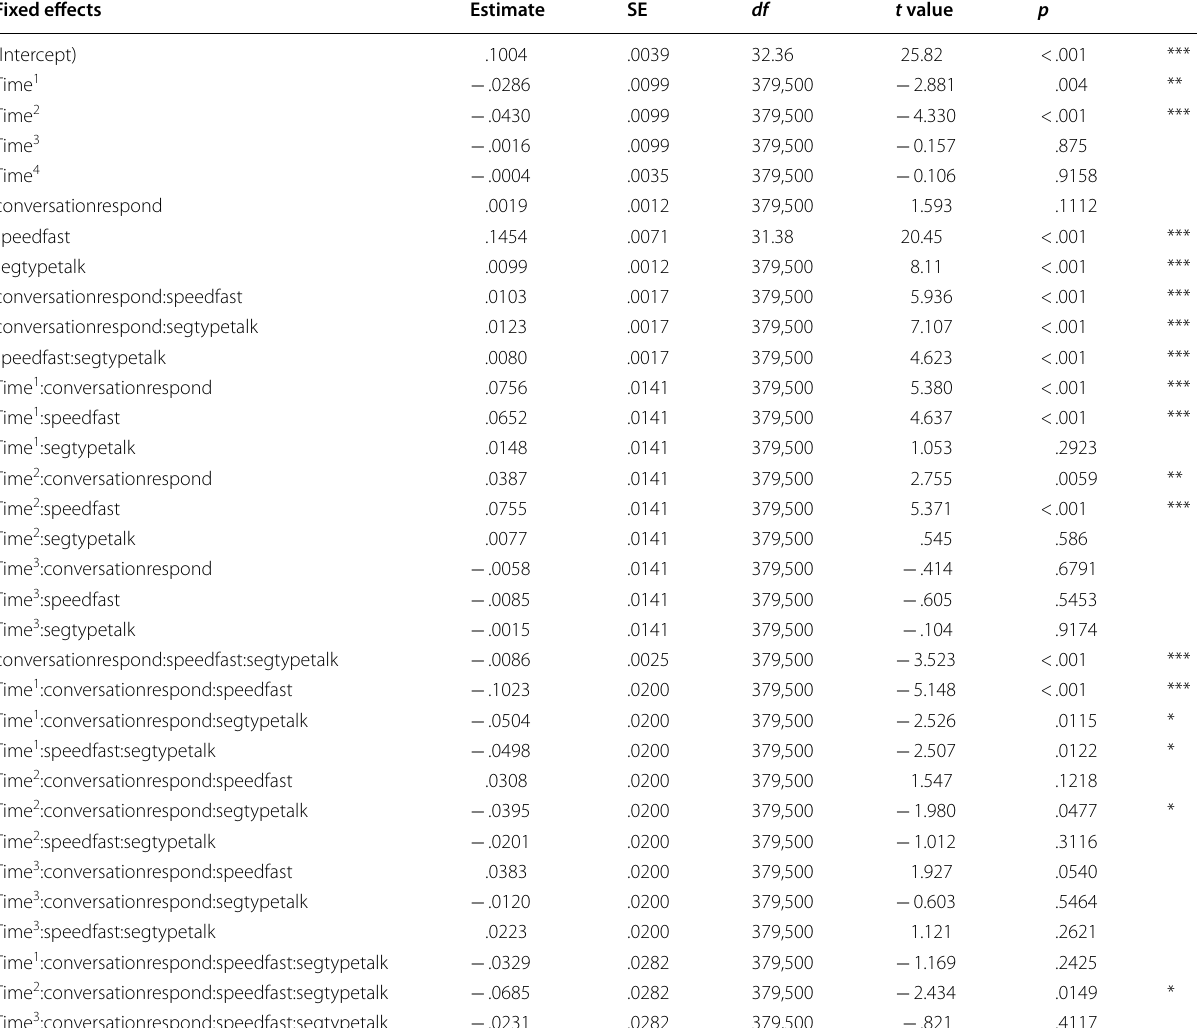
Table 3 Cubic model coefficients in